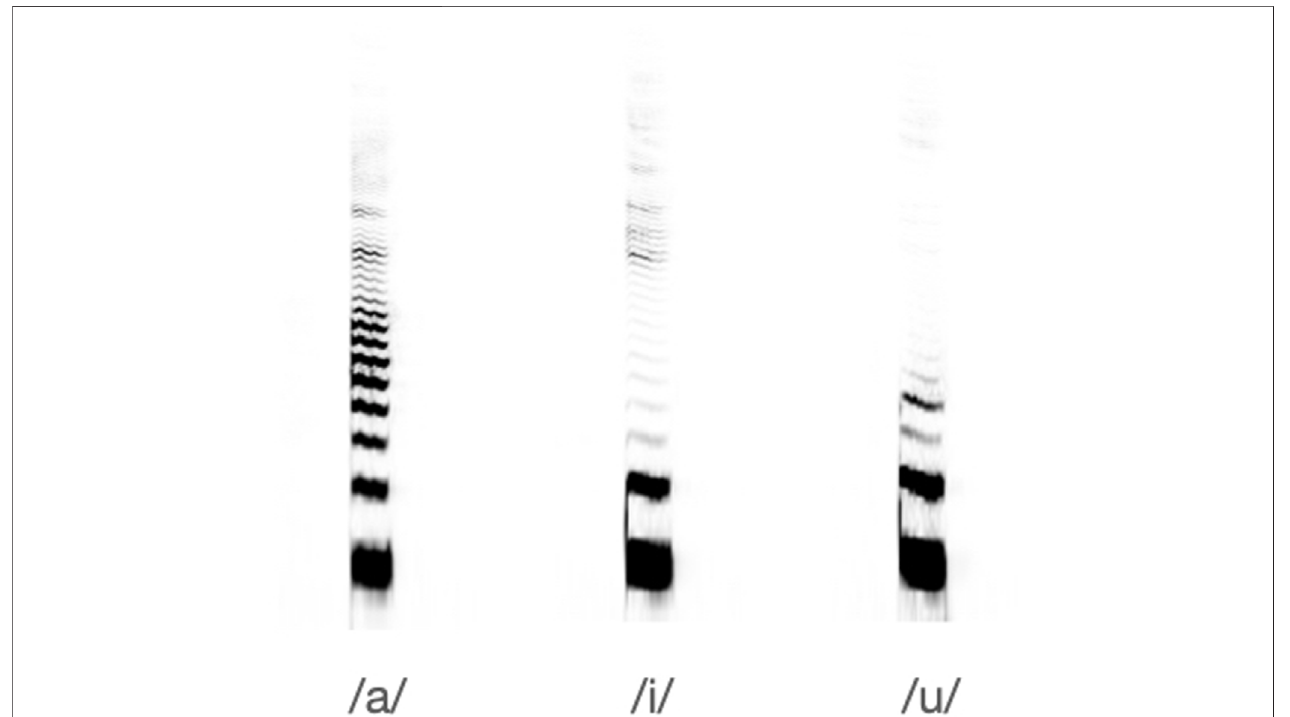
FIGURE 7 | Spectra of the vowels /i/, /u/ and /a/ as pronounced by a Yoruba native speaker.